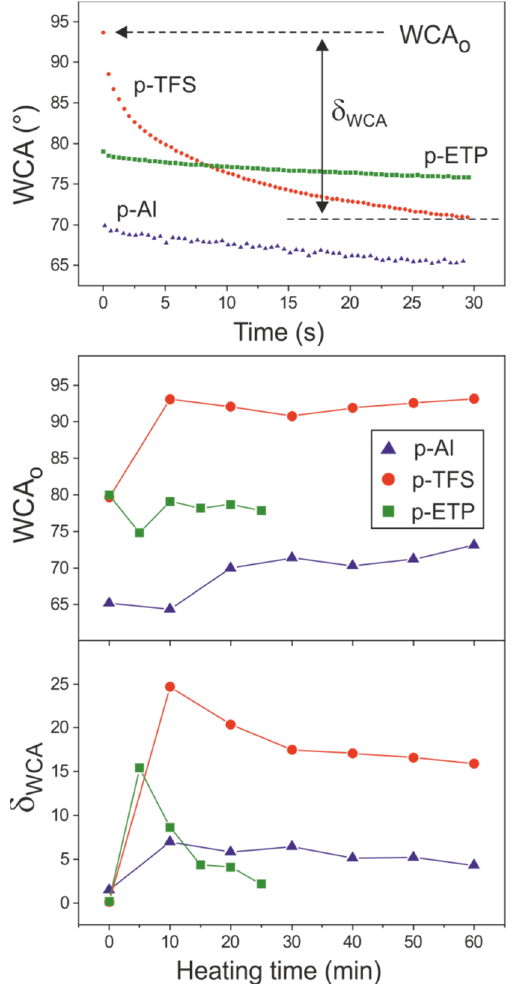
Figure 8. ( top ) Water contact angle (WCA) evolution with contact time on polyaleuritate films obtained at 200 ◦ C for 20 min on Al, TFS and ETP. ( bottom ) Initial WCA value (WCA o ) and reduction ( δ WCA ) after 30 s (spreading) for coatings prepared at 200 ◦ C and variable time on the three metal supports.